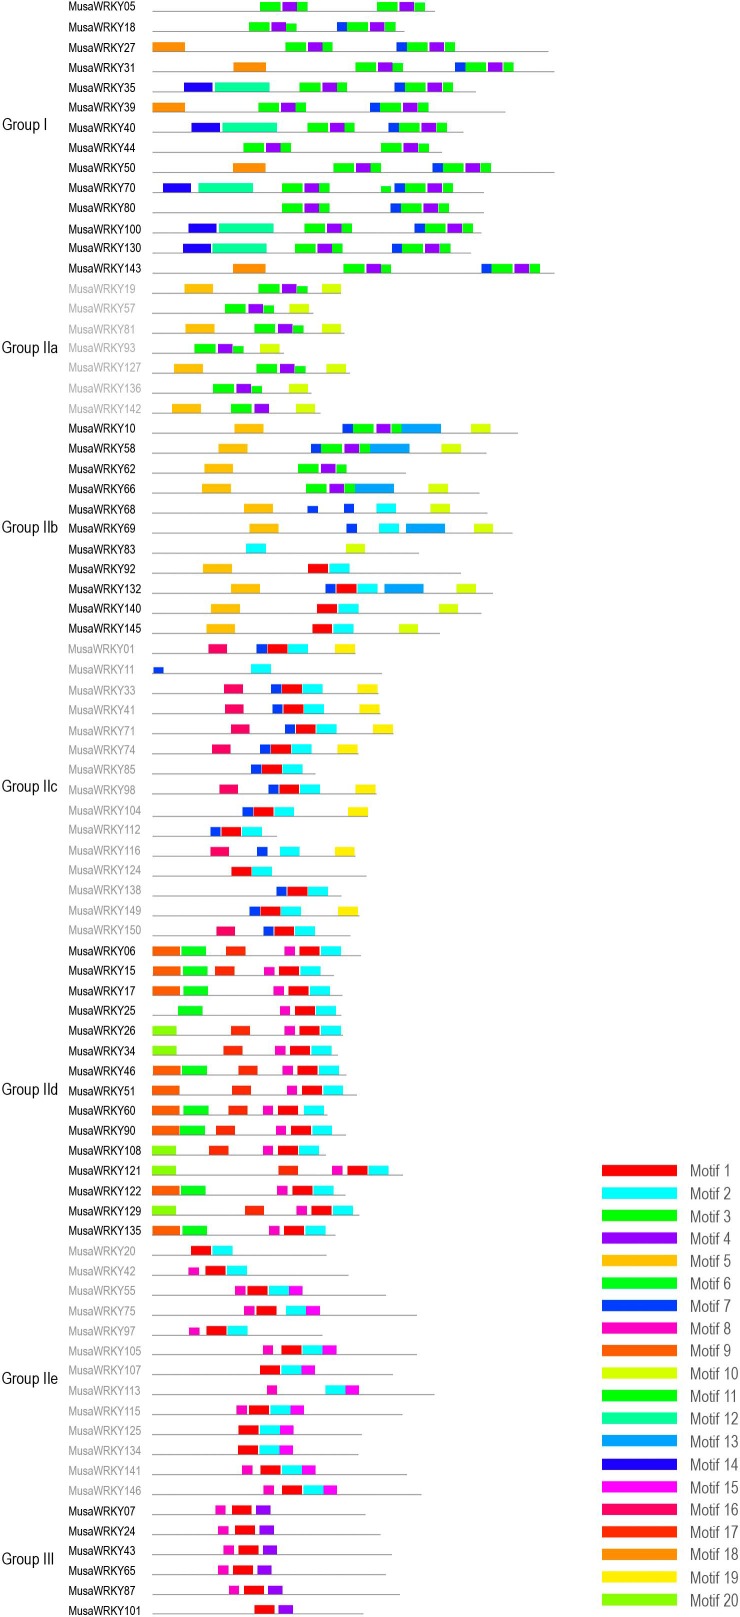
Conserved motifs of 81 Musa WRKY proteins.MEME was used to predict motifs and these motifs represented with boxes.